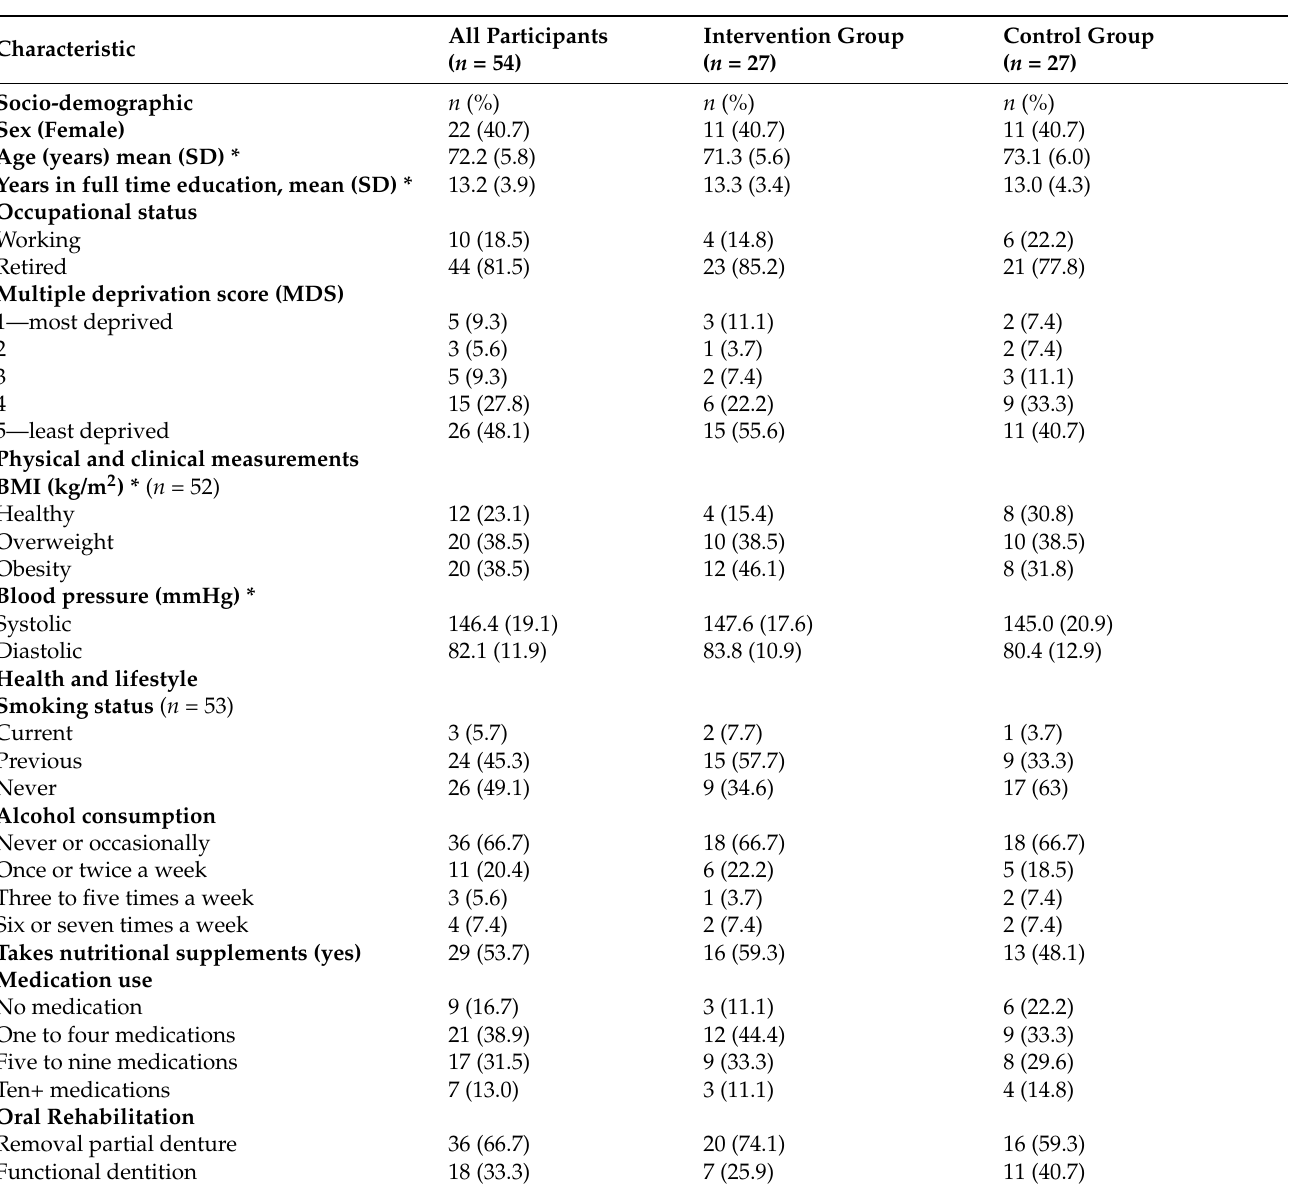
Table 3. Baseline characteristics of all participants and by randomisation